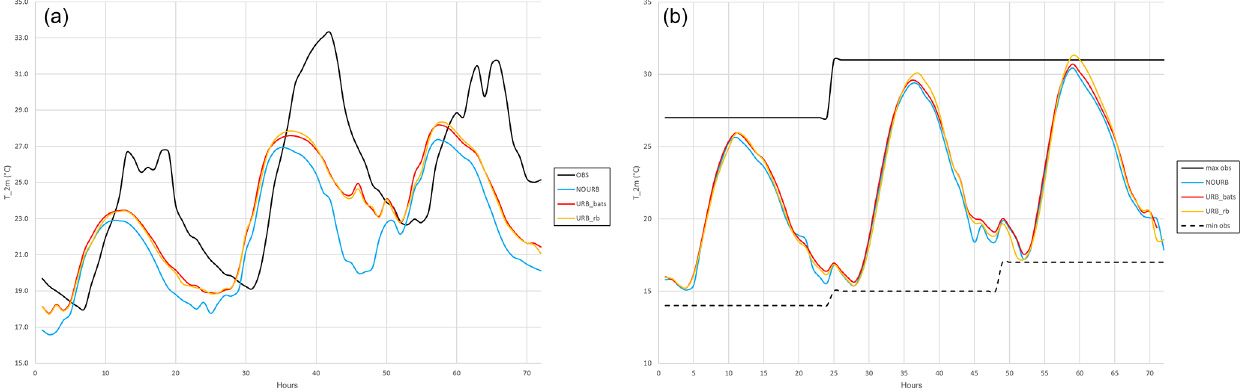
Figure 3. Time series of T_2m over the period 6–8 June 2019 at (a) the urban area of Naples and (b) the rural area of